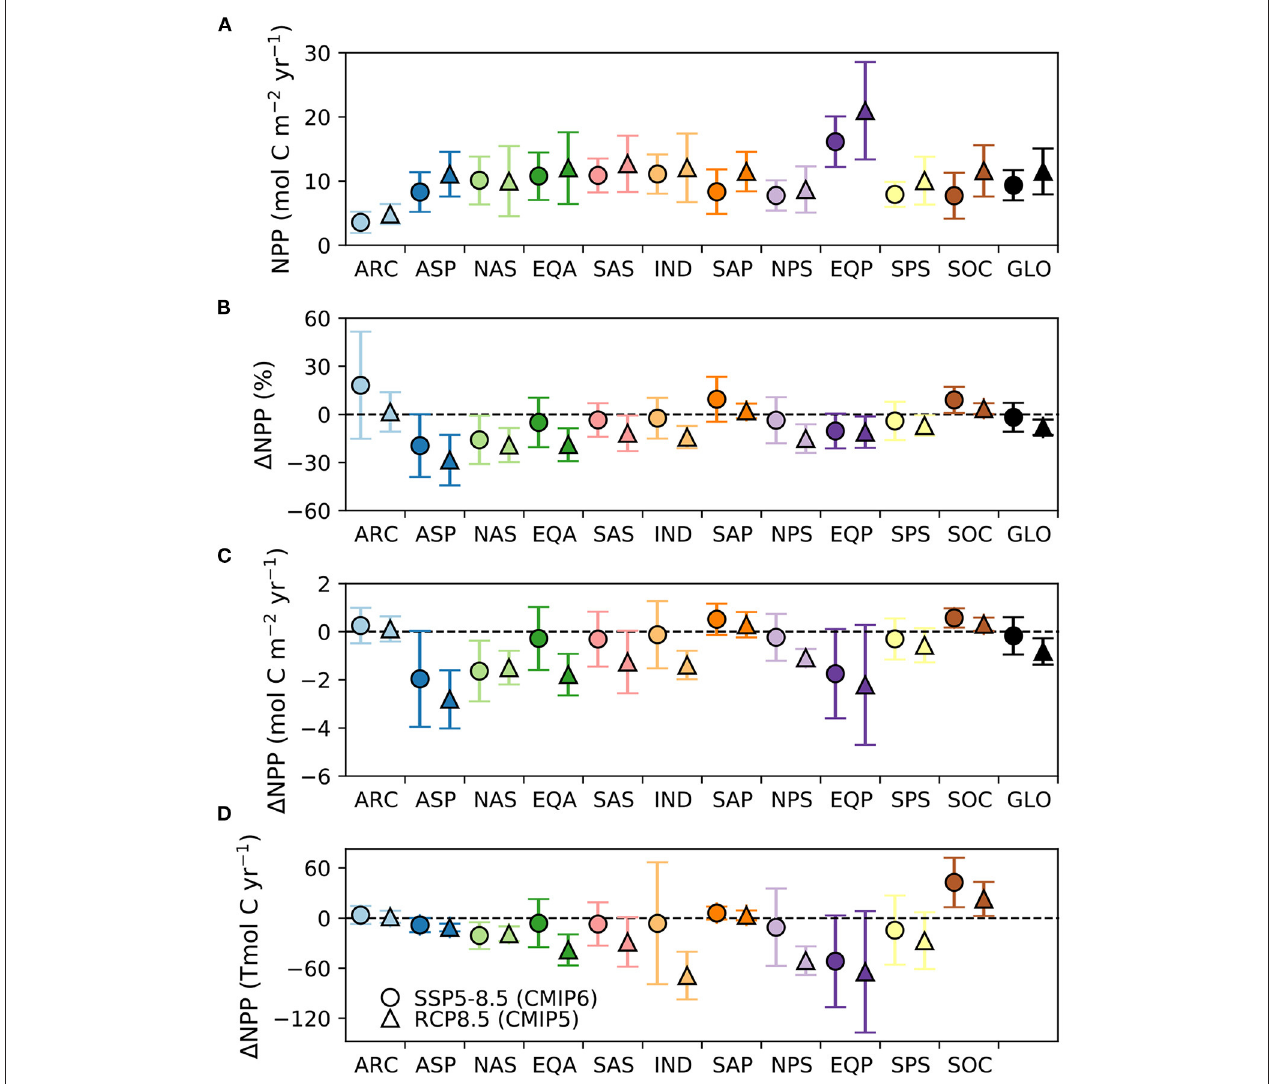
FIGURE 2 | Multi model mean and 1 σ uncertainty for 16 CMIP6 and 10 CMIP5 models on a province by province basis for (A) NPP levels during the historical era (1995–2014), and projected changes in annual NPP on a (B) percent, (C) mol C m − 2 and (D) Tmol C basis (all relative to 1995–2014). CMIP6 results are from the 16 models using the SSP5-8.5 scenario, while CMIP5 results are from the 10 models using the RCP8.5 scenario. The global results are not included on panel d as they distort the